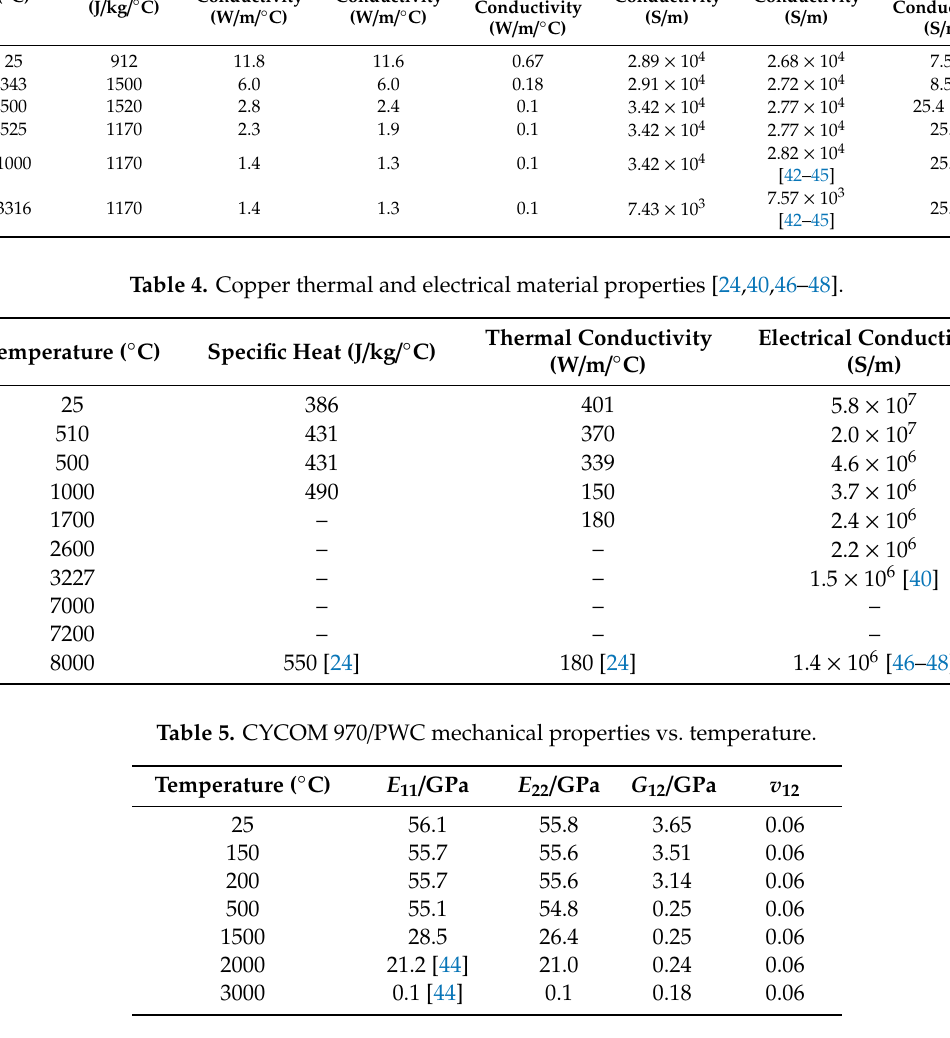
Table 5. CYCOM 970/PWC mechanical properties vs. temperature